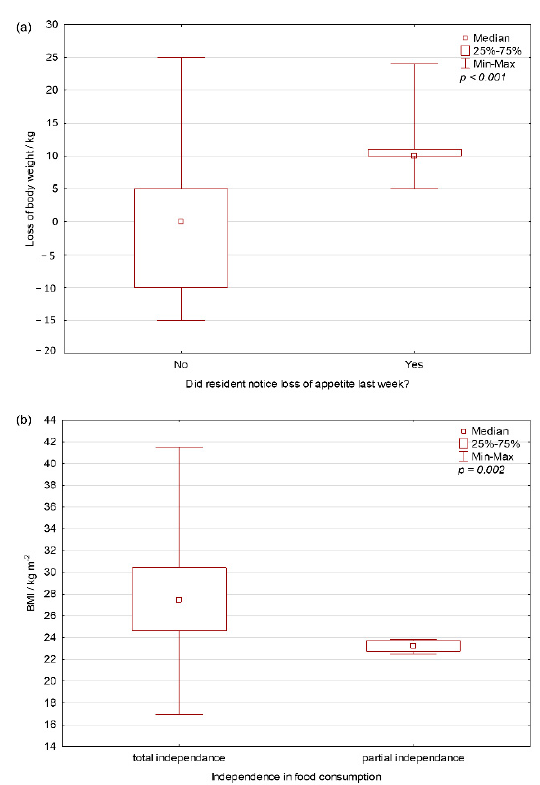
Figure 2. Loss of body mass: ( a ) comparison of user groups concerning food intake; and ( b )